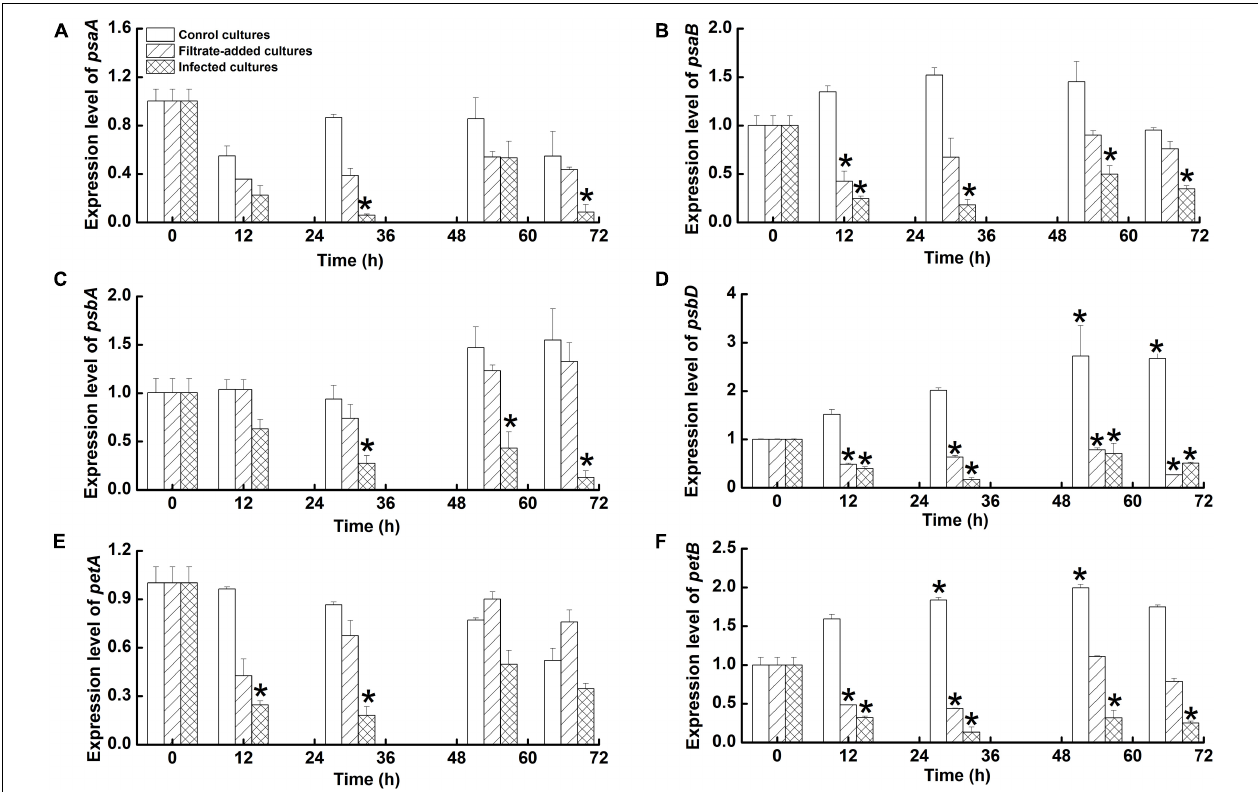
FIGURE 6 | Relative mRNA expressions of photosynthesis gene in Akashiwo sanguinea during the course of infection by Amoebophrya sp. at a dinospore: host ratio of 10: 1. Temporal mRNA expression of psaA (A) , psaB (B) , psbA (C) , psbD (D) , petA (E) , petB (F) were quantitatively assessed using the qRT-PCR assays. The transcriptional expression was calculated by the 2 − (cid:49) (cid:49) Ct method using the 18S rRNA, TUA and GAPDH as the reference gene. Error bars indicate the standard error. Statistical significances across control in the same time of sampling were indicated with an asterisk ( P <